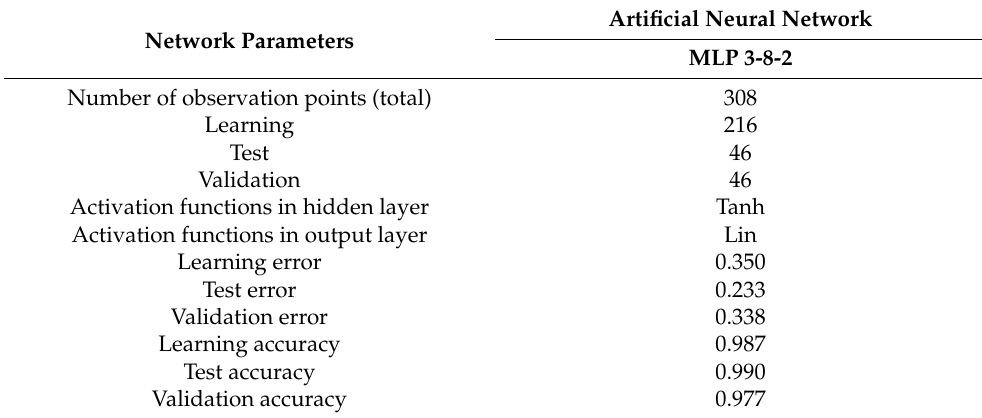
Table 8. Basic information on the structure and values of learning, test, and validation error computed for MLP neural networks adopted as the neural network model to predict the C. freundii population and the production of 1,3-propanediol on glycerol-based